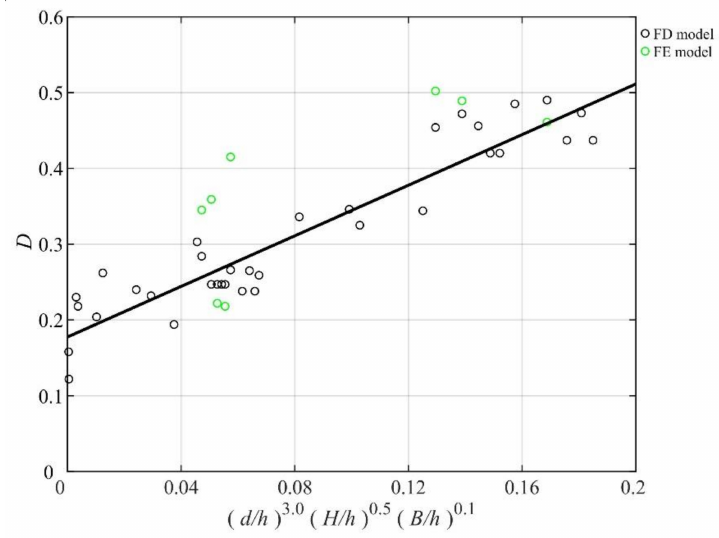
Figure 10. A parameter study of the relation of the dissipation coefficient D with the combined parameters of d/h , B/h, and H/h (the black line denotes the optimal regression; black and green circles denote FD and FE model results,